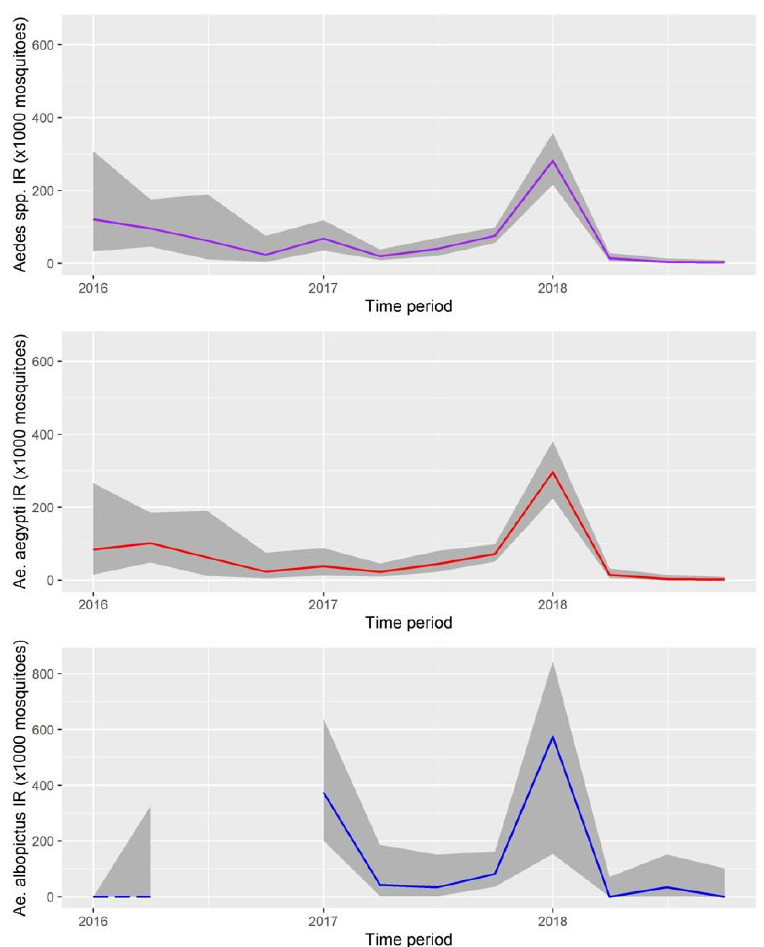
Figure 3. Infections rates without virus distinction with their respective 95% confidence A: IRs species for both pooled. B. IRs for Ae. aegypti. C. IRs for Ae. Albopictus , discontinuous line and space in year 2016 refers to lack of statistical meaning by analyzing only one pool for each of the two first